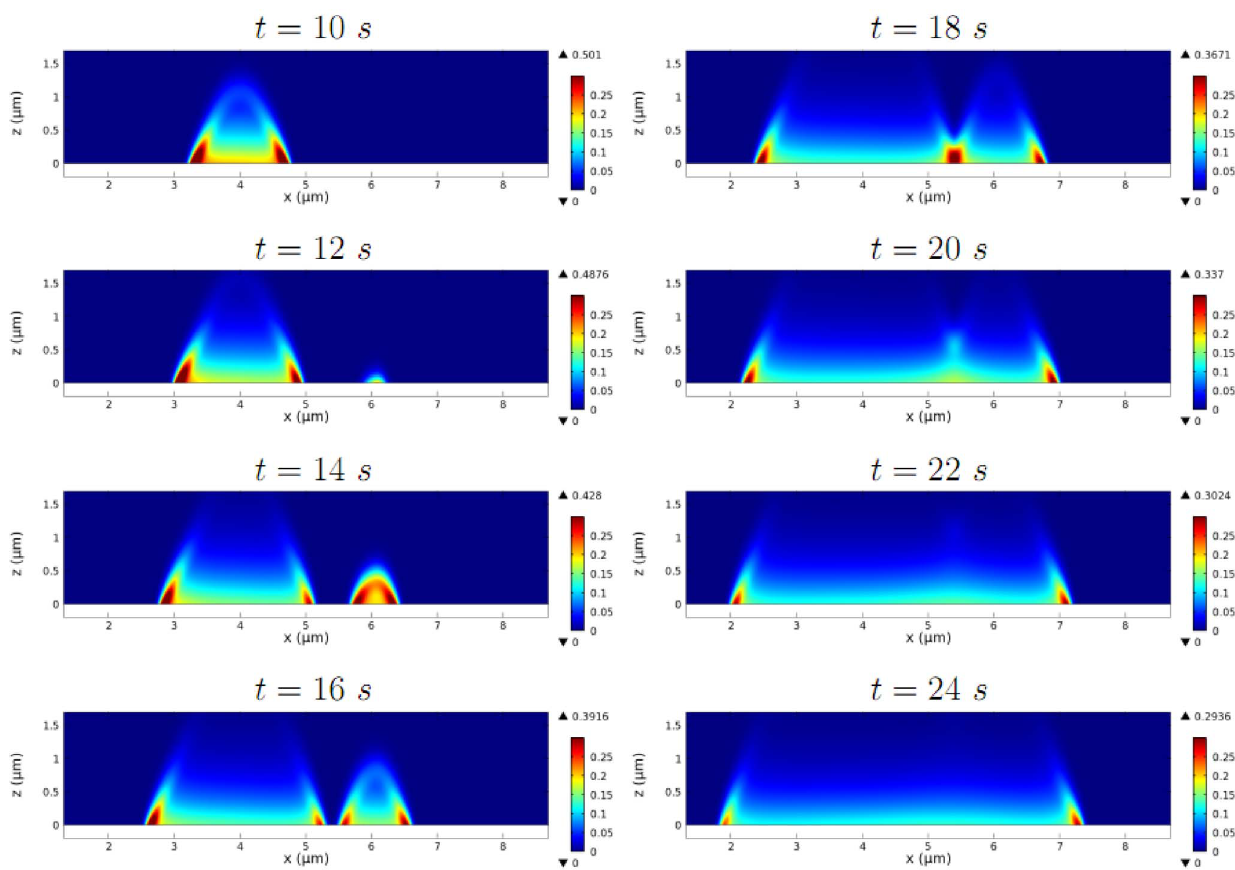
Figure 11. Annihilation of actin waves. Two wave fronts annihilate when they collide, combining the regions they enclose. The actin waves are initiated 5 s apart at x ~ 4 m m and x ~ 6 m m on a 10 m m | 5 m m domain. The image sequence displays evolution of the pointed end density.